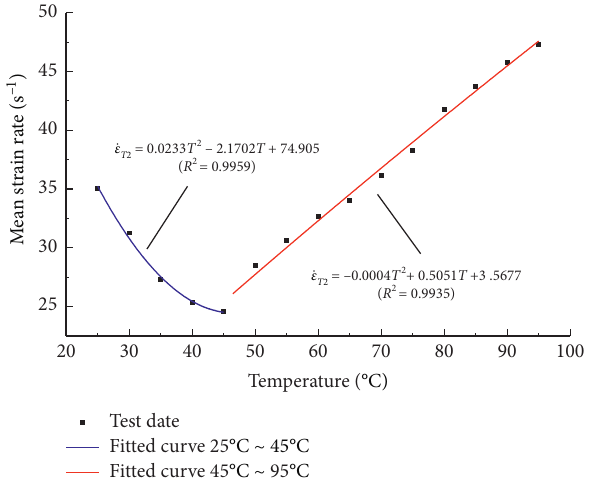
Figure 10: Fitting curve of change law between peak stress and average strain